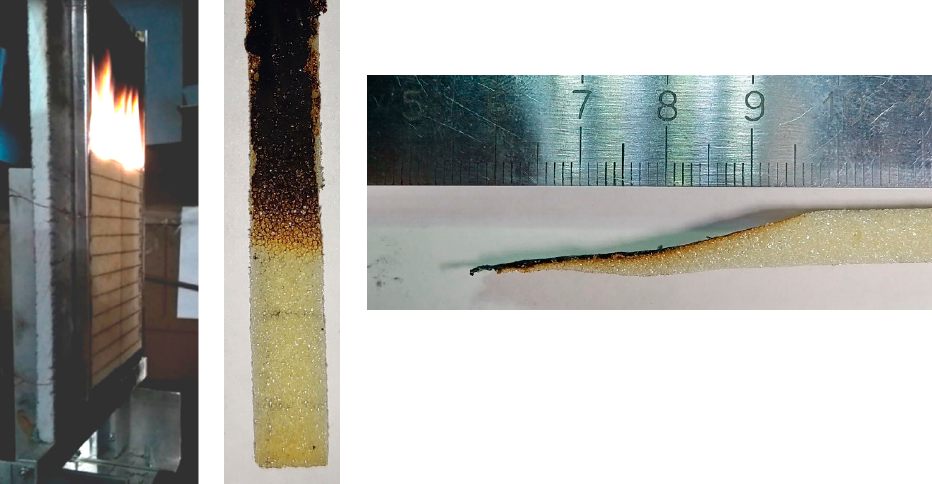
Figure 1. Experimental observation of the downward flame spread over the vertical polyurethane slab. Left to right : side view of the established propagating flame (horizontal lines are placed at a distance of 1 cm); front and side view of the extinguished specimen.